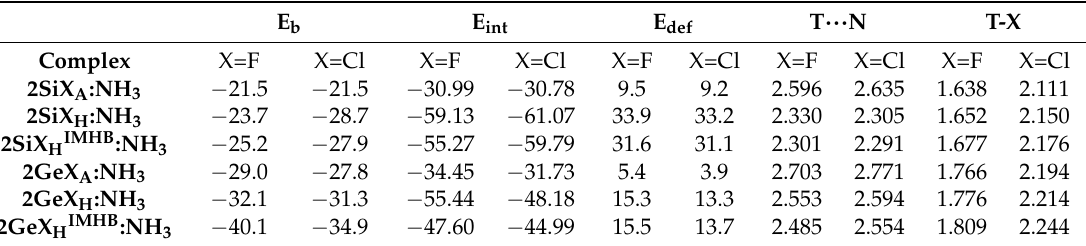
Table 5. Binding energies (E b ), interaction energies (E int ) and deformation energies (E def ), at